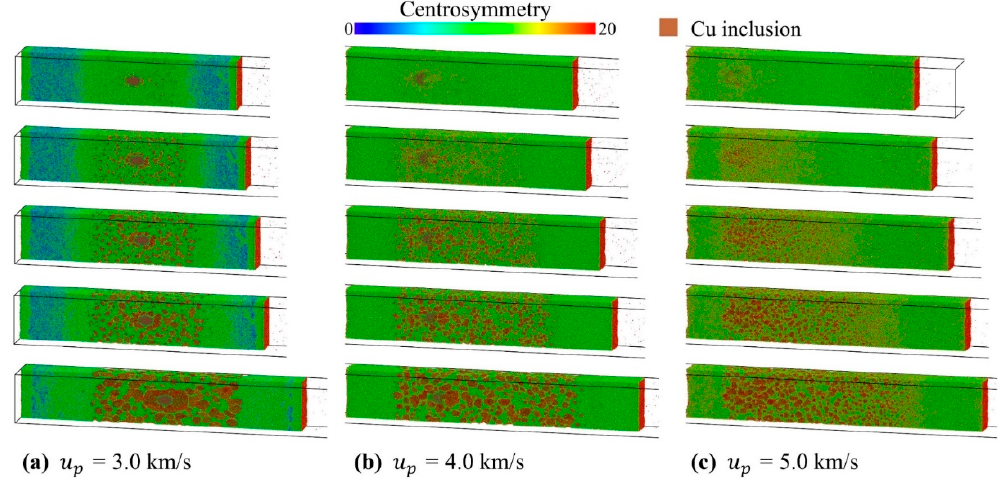
Figure 12. Microstructure evolutions of Al–Cu during spallation at different piston velocities. ( a ) u p = 3.0 km/s; ( b ) u p = 4.0 km/s; ( c ) u p = 5.0 km/s. The atoms are color-coded by CSP.